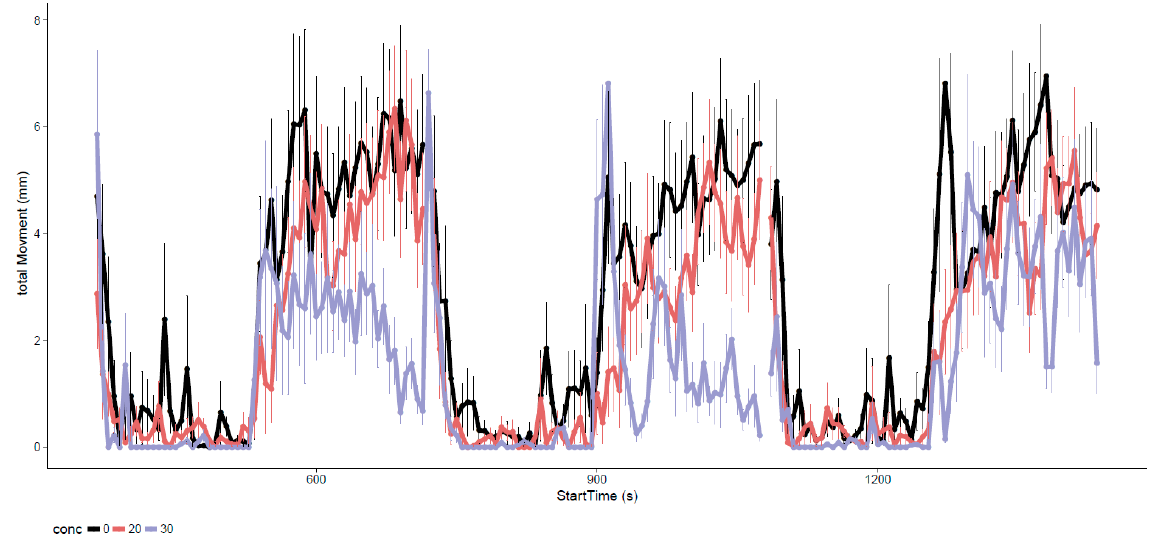
Figure 3. Larval photomotor response to alternating light and dark cycles after static exposure of DCB-230. Data are reported as mean ± standard deviation at each second time bin. Only concentrations that comprised 70% phenotypically normal animals are displayed.